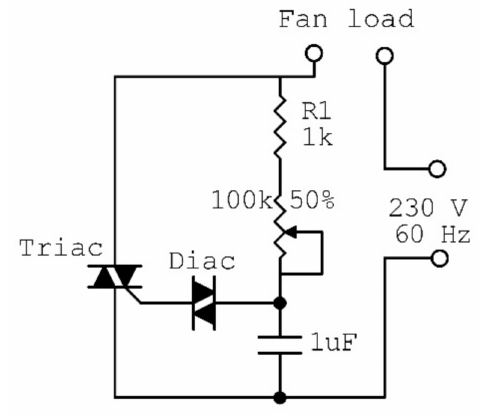
Figure 3. Circuit diagram of fan speed